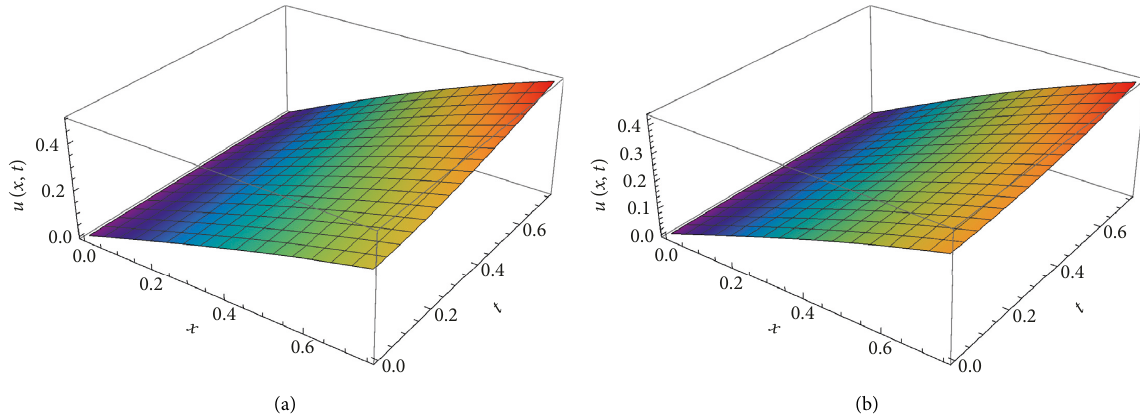
Figure 3: The graphs of the approximate iterative solution u ( x,t ) for (25) through various values of x, t at α � 0 . 5 , 1, respectively. (a) The graph of the approximate iterative solution u ( x,t ) for (25) through various values of x,t at α � 0 . 5. (b) The graph of the approximate iterative solution u ( x,t ) for (25) through various values of x, t at α � 1.